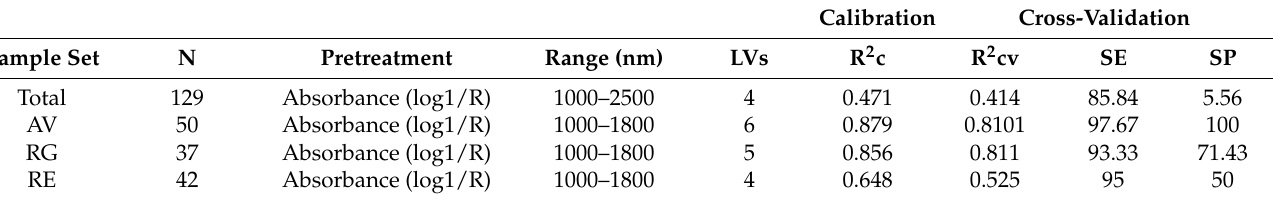
Table 2. PLS-DA results of the classification of Normal and DFD beef (Longissimus thoracis muscle) using best-fitting prediction equations for total, Asturiana de los Valles (AV), Rubia Gallega (RG), and Retinta (RE) sample sets in calibration and cross-validation obtained after spectral pretreatments. Calibration